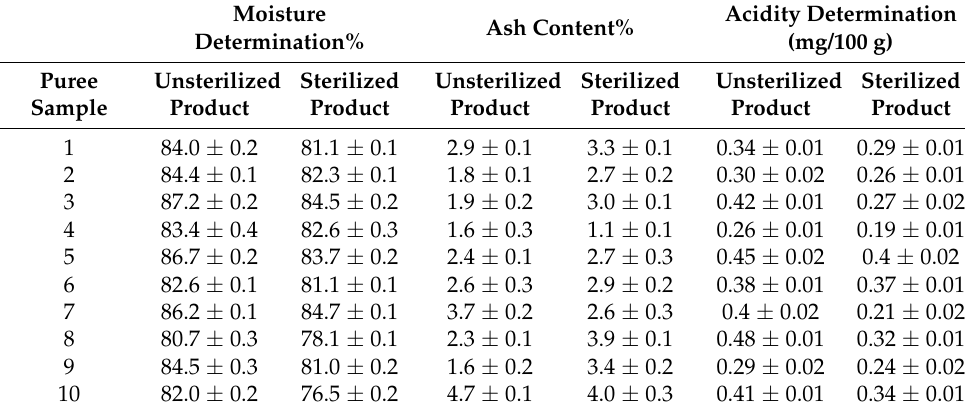
Table 3. Moisture, ash content and titratable acidity